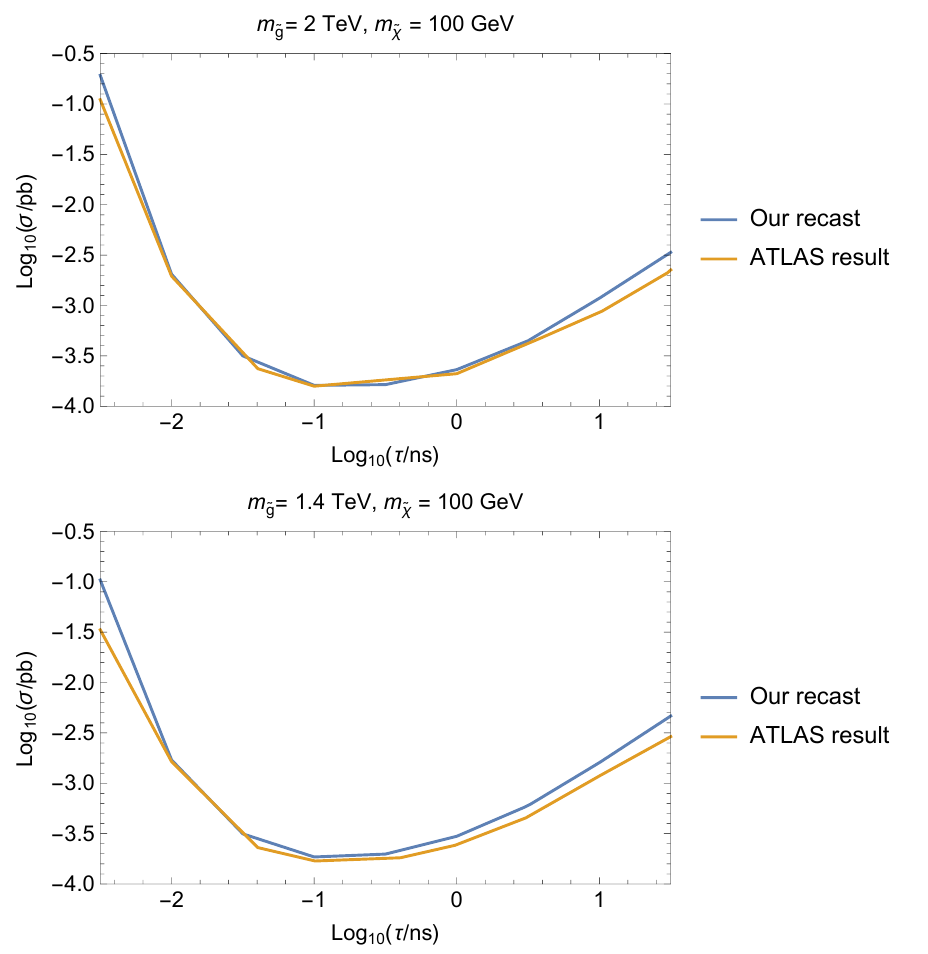
Figure 13 . Excluded cross sections at 95% C.L. as a function of the gluino lifetime, for a long lived gluino decaying to a quark pair and a neutralino, compared to the published result from ATLAS [45]. The gluino mass is (cid:12)xed to 2 TeV (top) or 1.4 TeV (bottom). The neutralino mass is (cid:12)xed to 100